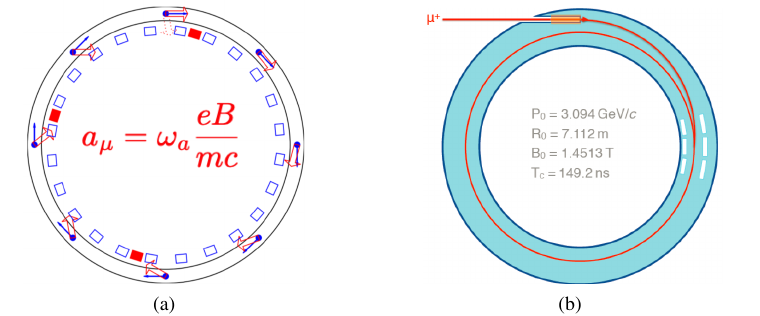
Figure 1: (a) The spin precession of muons utilised in order to measure a µ . The blue arrows show the muon momentum, whilst the red arrows indicate the muon spin (and corresponding decay positron direction). (b) The injection and storage of muons, where the 3 kicker plates are shown in white at 90 degrees from the injection point. Here, P 0 is the "magic" muon momentum, R 0 is the orbit radius, B 0 is the field magnitude of the storage ring magnet and T c is the cyclotron